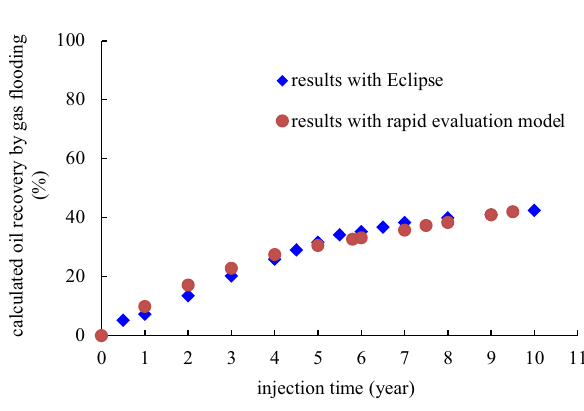
Fig. 7 Comparison on the oil recovery by surfactant flooding